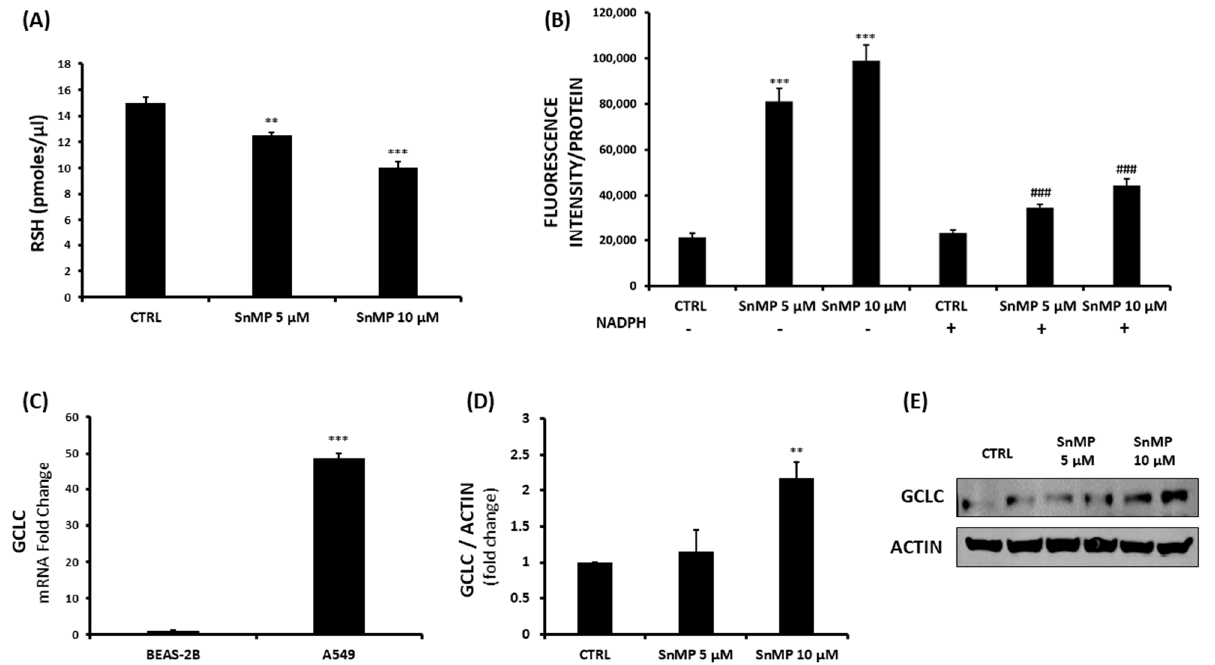
Figure 3. ( A ) Measurement of non-protein thiol group (RSH) concentration after SnMP (5 µ M and 10 µ M) treatment on A549 cells (** p < 0.01, *** p < 0.001 vs. CTRL). ( B ) Evaluation of the effect of SnMP on ROS levels with (+) or without (-) the addition of 10 µ M NADPH in the A549 cell line ( ### p < 0.001 vs. SnMP treatment, *** p < 0.001 vs. CTRL). ( C ) Determination of basal expression of the GCLC gene in A549 and BEAS-2B cell lines (*** p < 0.001 vs. BEAS-2B). ( D , E ) SnMP (5 µ M, 10 µ M) effect on GCLC protein levels on the A549 cell line (** p < 0.01 vs. CTRL). Results are expressed as mean ± SEM.